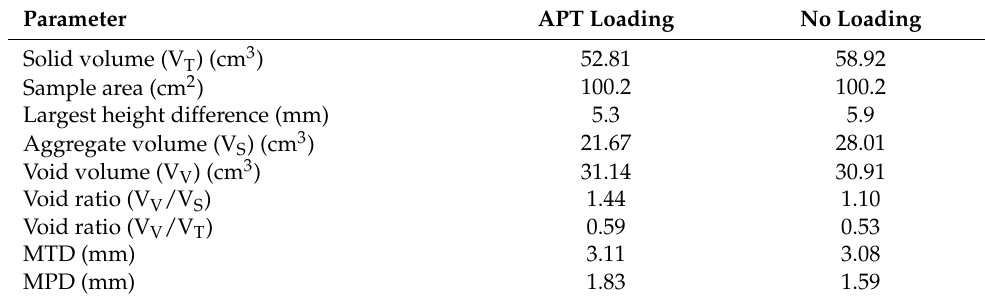
Figure 14. A 3D scan of the 20 mm Cape seal. Left: APT loading. Right: no loading. Table 4. Volume and void ratios calculated from a statistical analysis of 3D scans of the Cape seal.